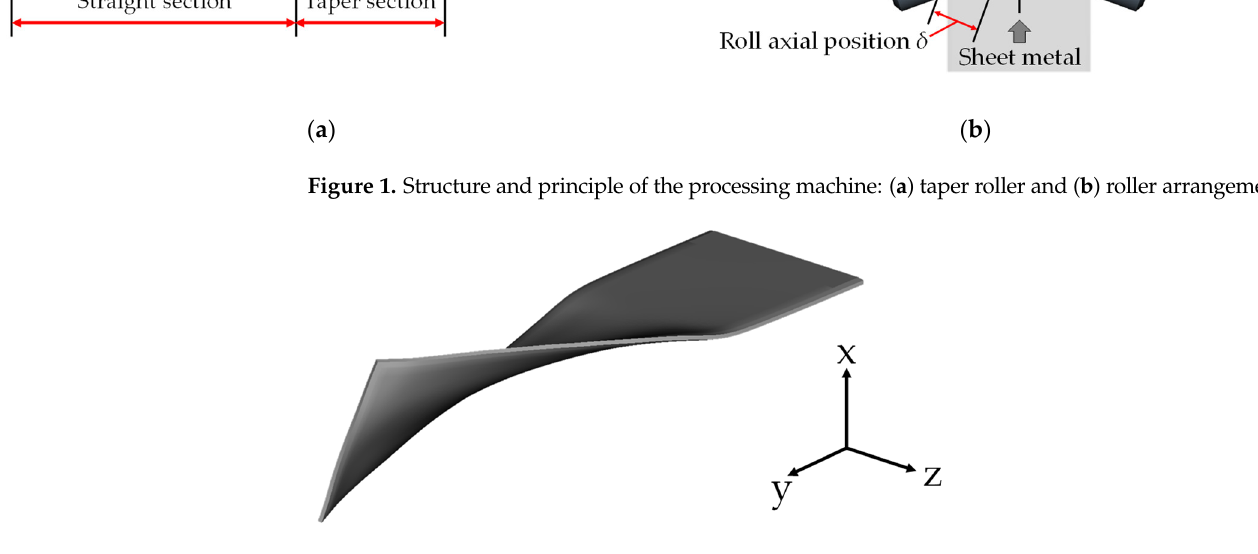
Figure 2. Twisted sheet metal.